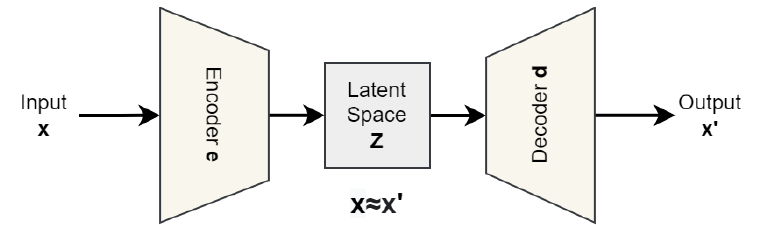
Figure 2. Autoencoder architecture visualised (courtesy of Ref.